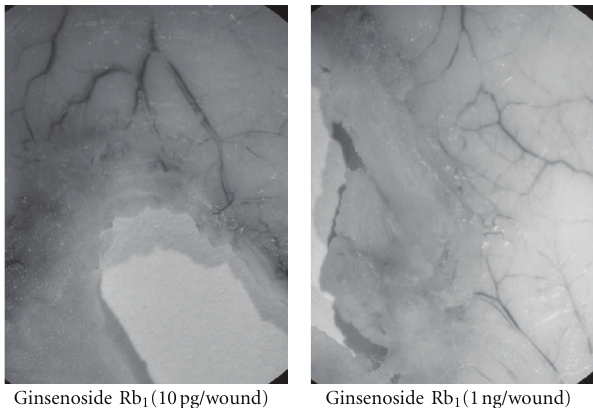
Figure 5: Photographs showing neovascularization from the tissue surrounding the burn and the e ff ects of the topical application of ginsenoside Rb 1 [26]. The experiments were performed as described in Figure 3. On day 9, any angiogenesis in the site surrounding the burn wound was photographed using a stereoscopic